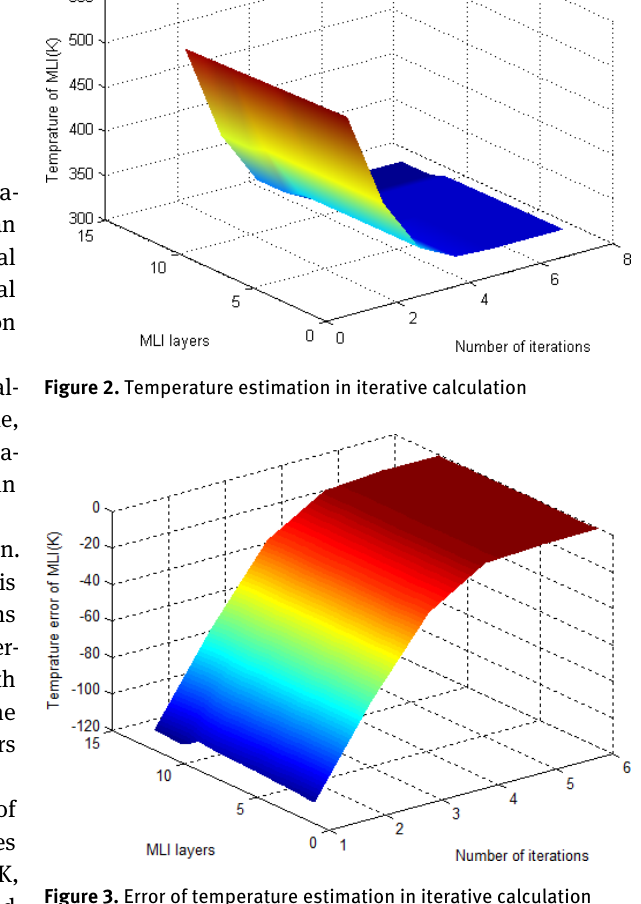
early stage of iteration and gradually slows down in the later stage. It can be seen that even when the initial temper- ature estimation differs greatly from the actual